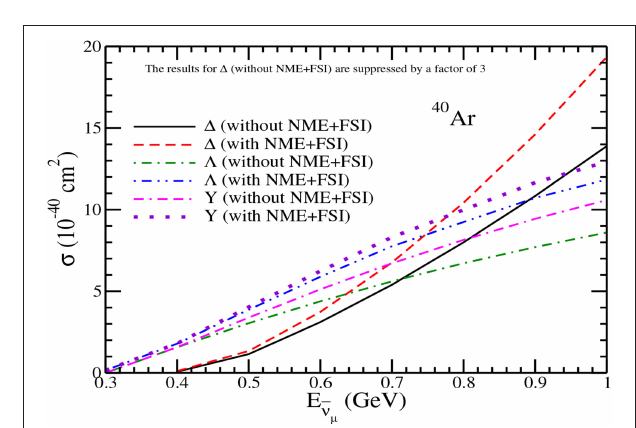
FIGURE 16 | Results for the charged current π o production in 12 C with and without NME+FSI. The results are presented for the pion production from 1 , 3 , and total hyperon Y 3 6 with and without NME+FSI. Notice that the = + results of 1 without NME+FSI are suppressed by a factor of 3 and the results with NME+FSI are suppressed by a factor of 2.